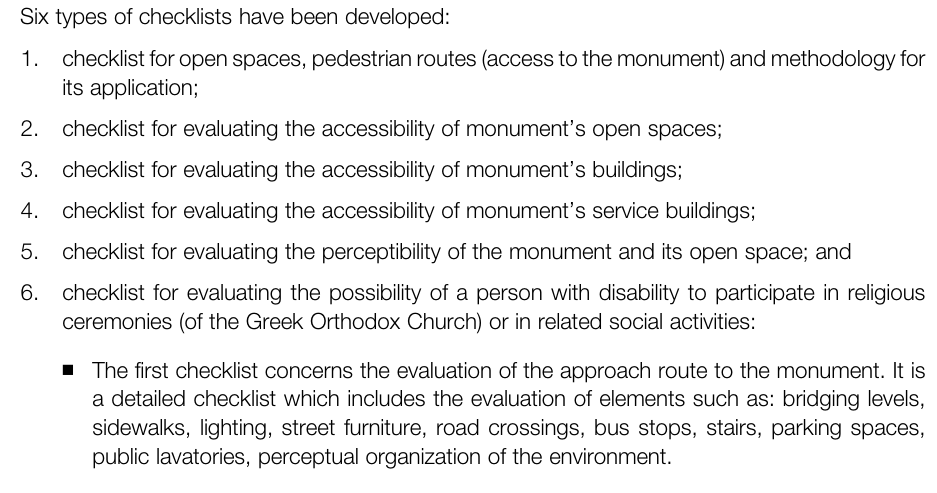
EVALUATION OF THE EXISTING ACCESSIBILITY /PERCEPTIBILITY OF